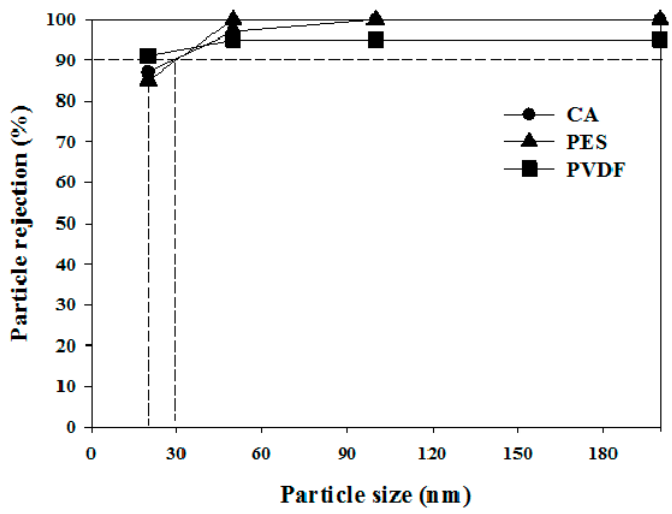
Figure 3. Polystyrene particle rejection results for the prepared membranes.